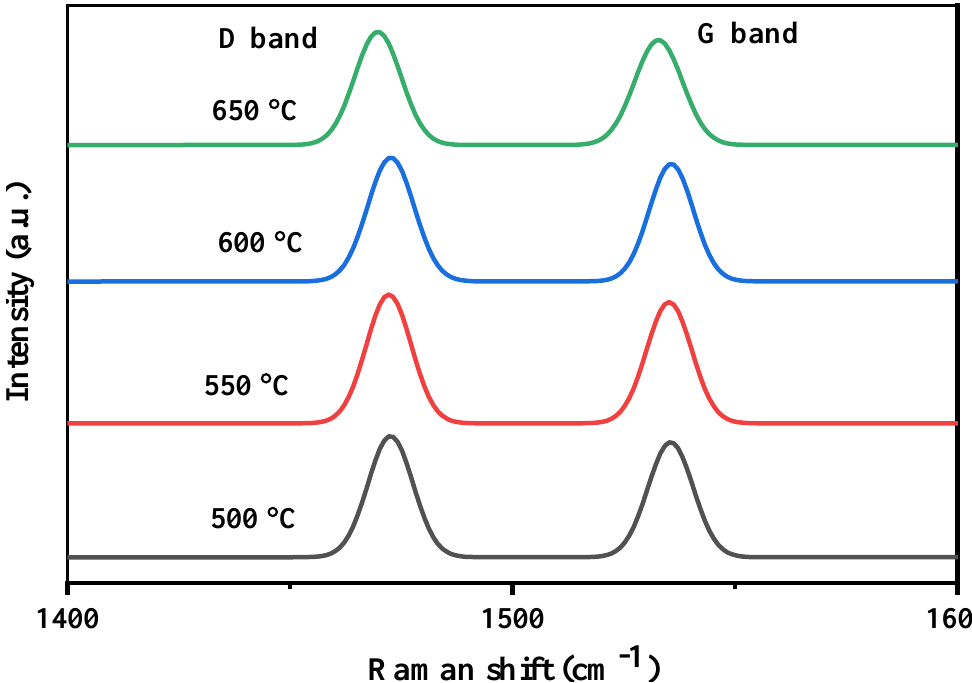
Figure 13. Raman spectra of the Ni-Al-H-600 catalyst obtained at different reaction temperatures (500, 550, 600, and 650 °C).